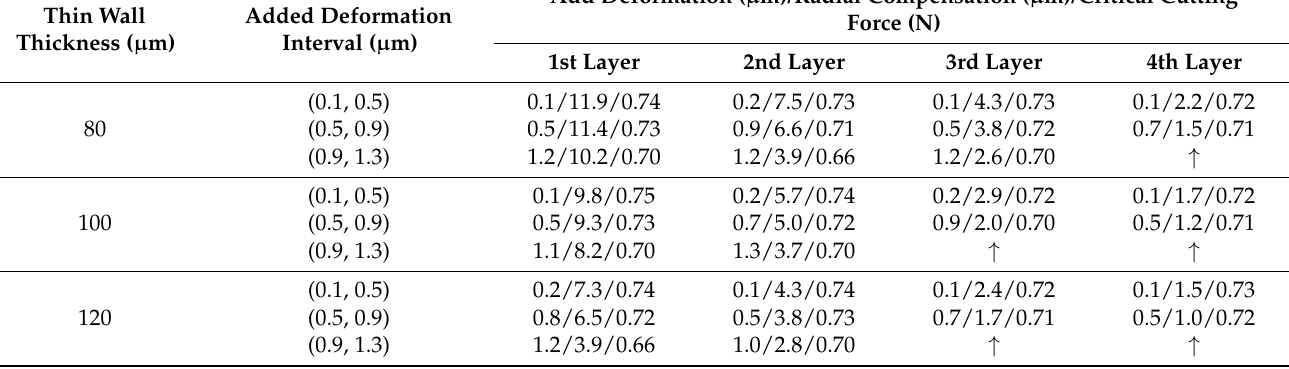
Table 8. Optimization experiment parameters.